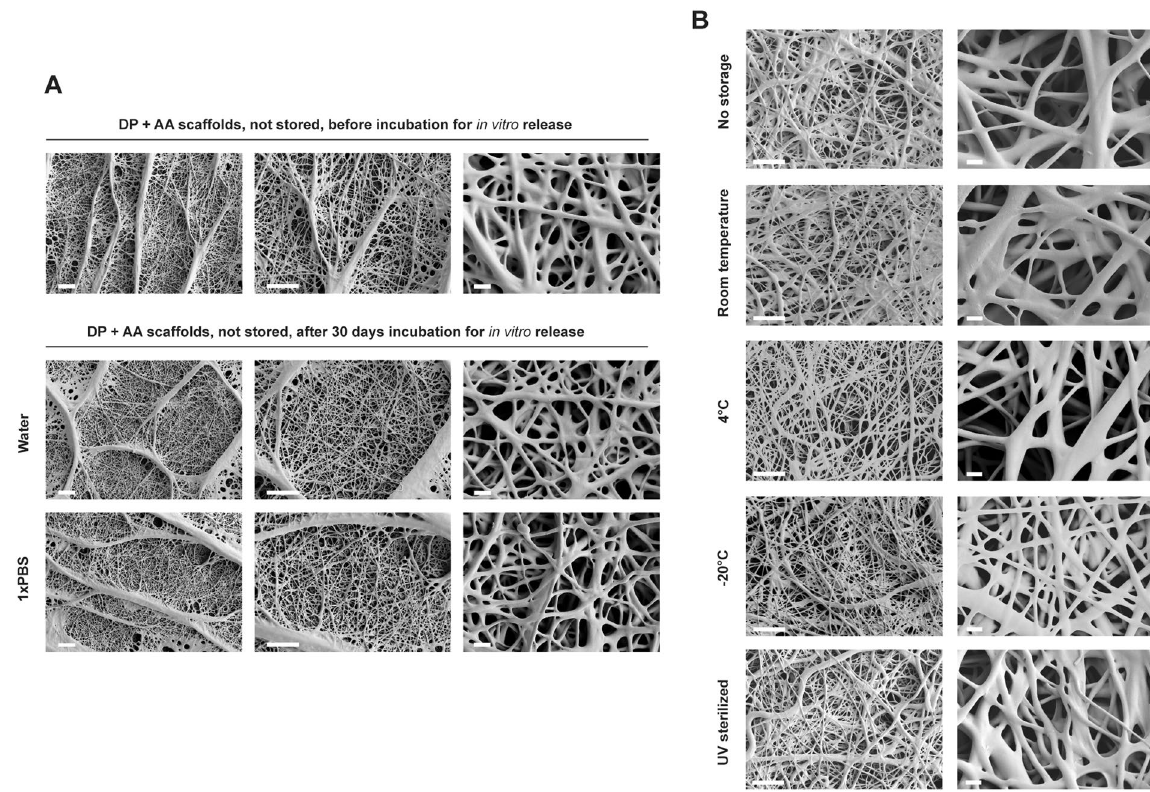
Figure 2. Scaffold morphology of non-stored and stored bioactive DP scaffolds. ( A ) SEM micrographs of non stored DP scaffolds with incorporated ascorbic acid, before or after 30 days in vitro release in water or 1xPBS. ( B ) SEM micrographs of non-stored and differently stored DP scaffolds with incorporated ascorbic acid, after 14 days in vitro release in water. Scale bars: 40 μ m (lower magnification) and 4 μ m (higher